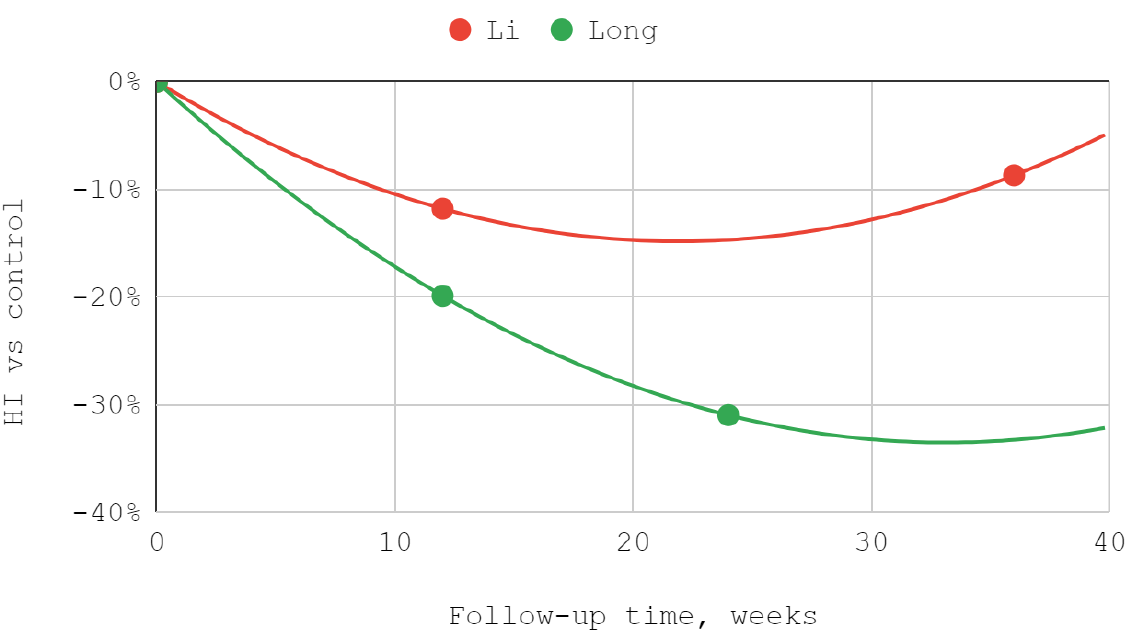
Figure 9. The efficiency of inferior versus superior compartment TMJ treatment in maximum mouth opening (MMO) domain over time.